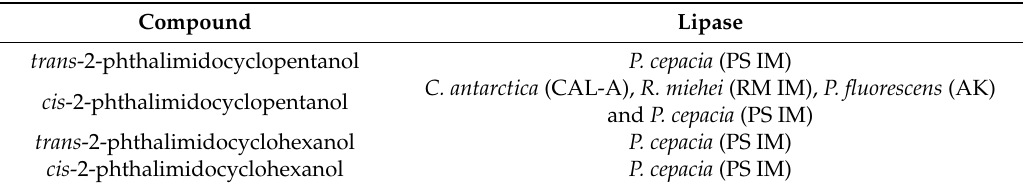
Table 3. Efficient lipases for the kinetic enzymatic acylation of racemic trans - and cis -diastereoisomers